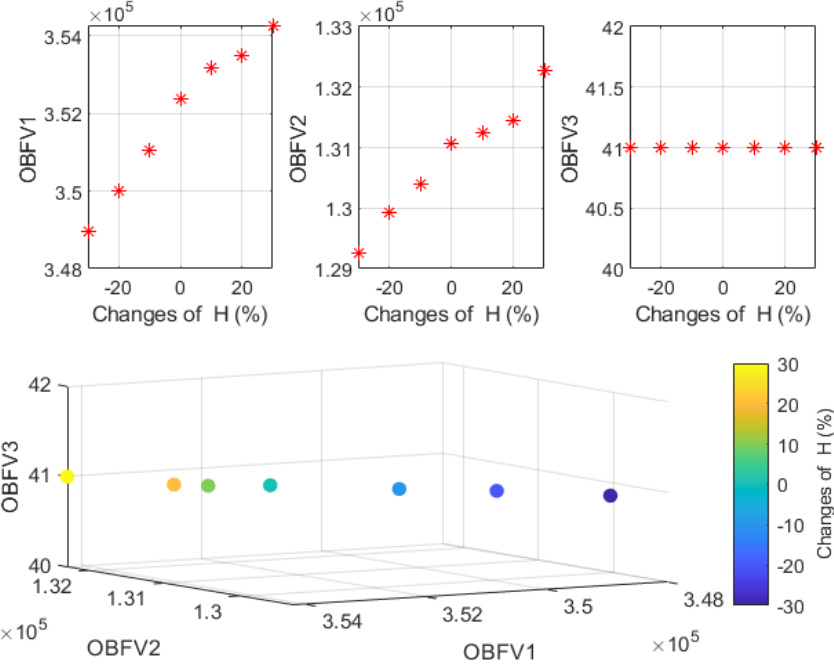
Figure 6. Trend of changes in the OBFVs in different value of parameter H. Table 8. OBFVs in changing effect of parameter α